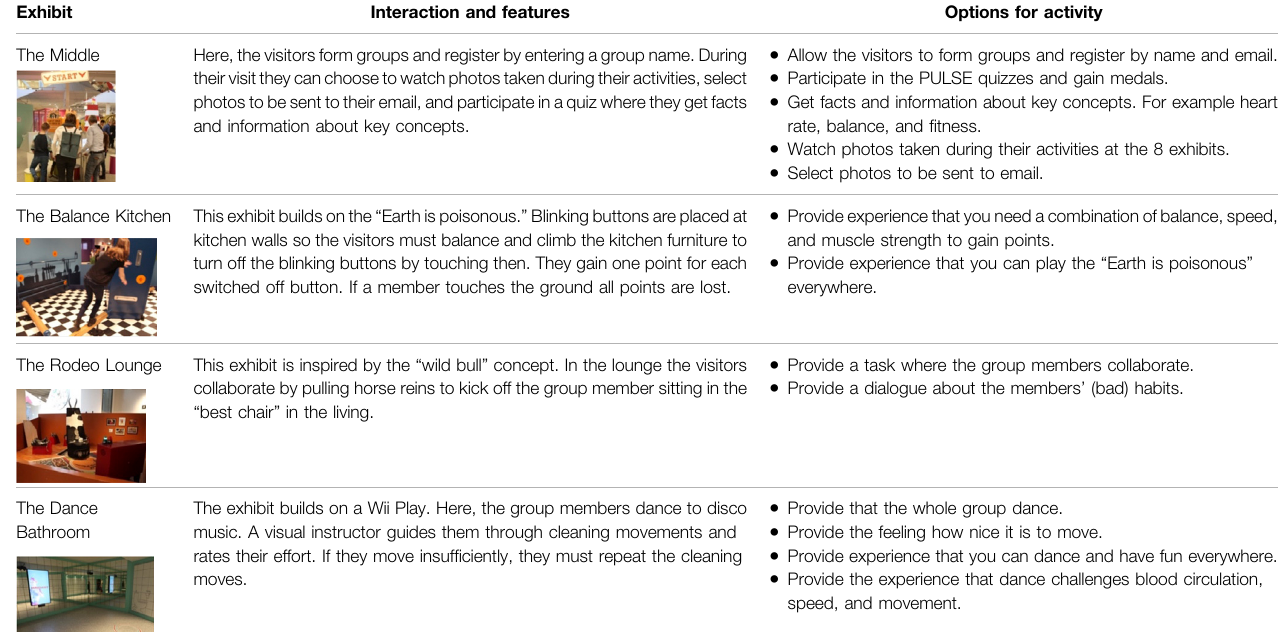
TABLE 1 | Description and photo of the Middle and the eight Pulse exhibits. Exhibit Interaction and features Options for